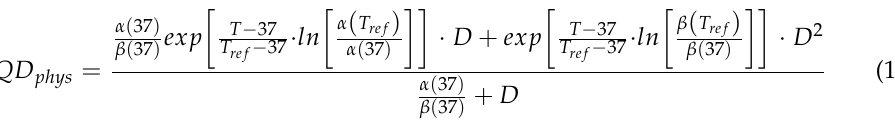
Table 3. Thermoradiobiological parameters applied in this study, with T ref = 43 ◦ C. Tissue α (37) / β (37) α (43) / α (37) β (43) / β (37) Prostate